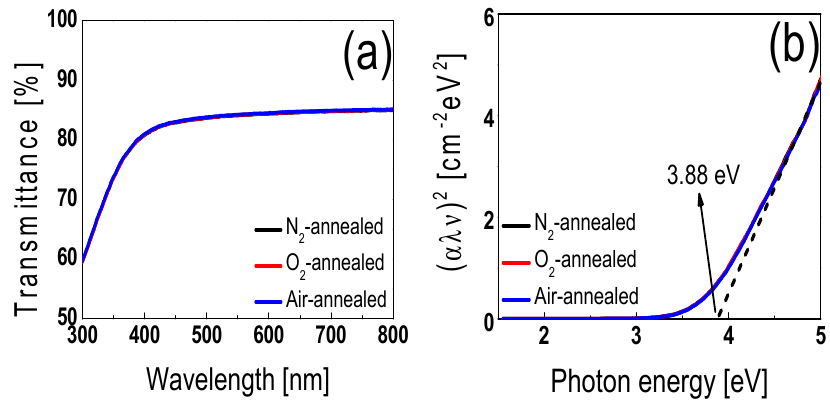
Figure 6. ( a ) Optical transmittance spectra recorded for N 2 -, O 2 -, and ai -annealed 20 nm-thick IGTO thin films. ( b ) Tauc plot constructed from the optical transmittance spectra.